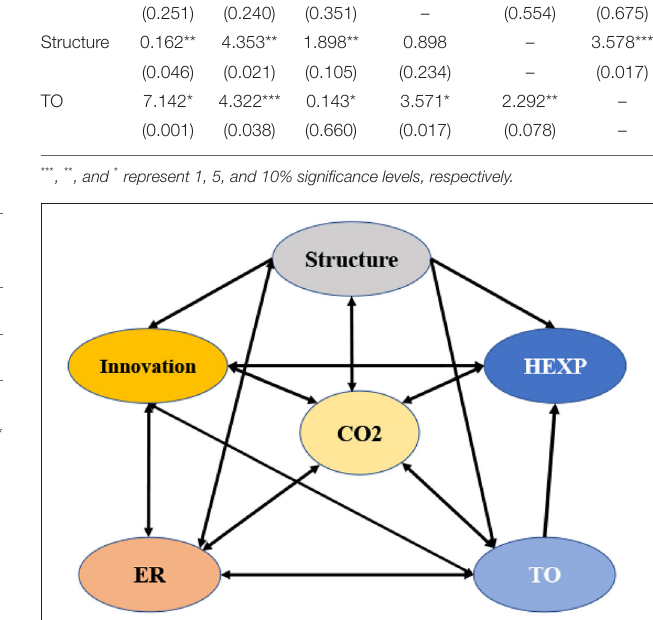
The arrow direction represents Granger causality (see Figure 3